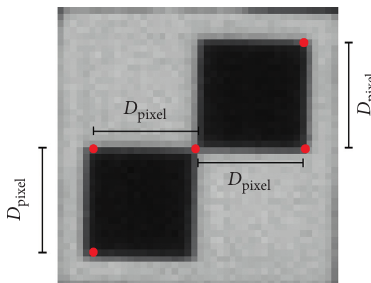
Figure 3: Schematic diagram of scaling factor solution.